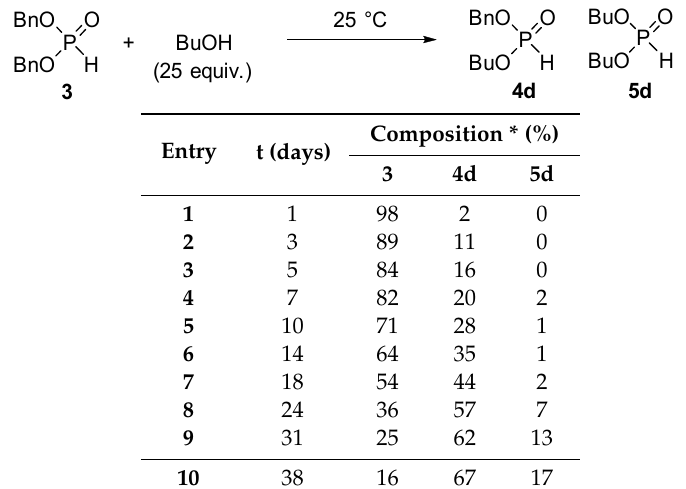
Table 6. Alcoholysis of dibenzyl phosphite ( 3 ) at room temperature.